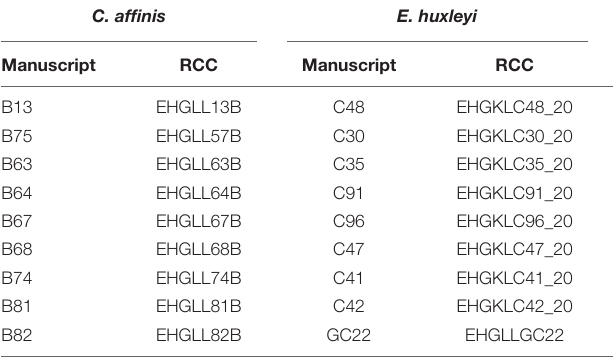
TABLE 1 | All genotypes used are listed in the column “manuscript” under the name used in here and are deposited in the Roscoff Culture Collection (RCC) under the name shown in the “RCC”